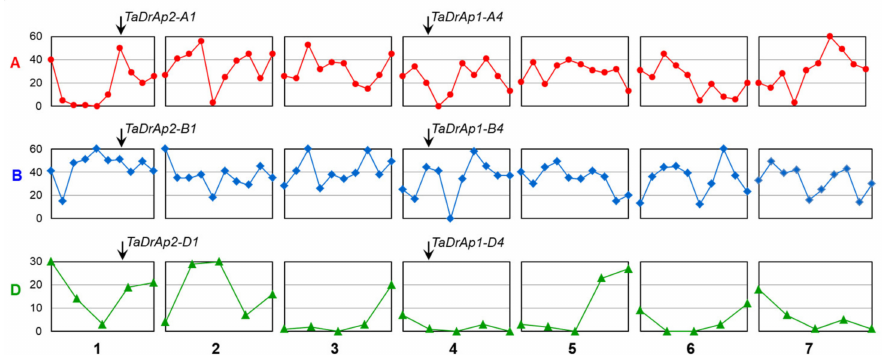
Figure 4. The distribution of 4806 e ff ective and mapped Single nucleotude polymorphisms (SNPs) extracted from the 40K microarray analysis, based on the annotated bread wheat genome cv. Chinese Spring. The SNPs were distributed along each of the seven groups of homeologous chromosomes, as indicated in boxes. Three genomes (A, B, and D) are shown in di ff erent colors and the numbers of identified SNPs are shown on the y -axis. For A and B genomes, SNPs were bulked into 10 bins of equal genetic distance in each chromosome, while only five bins were used for bulking SNPs for the D genome. The bins are shown as dots, squares, and triangles for A, B, and D, respectively. Positions of the two targeted genes, TaDrAp1 and TaDrAp2 , are indicated on chromosome bins by